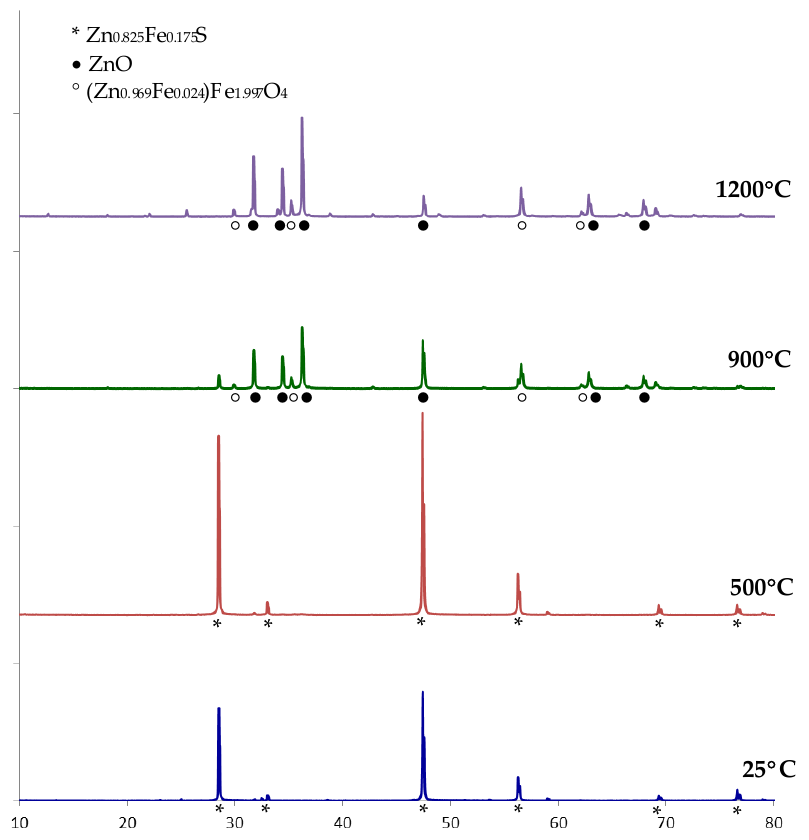
Figure 2. XRD patterns of raw (25 °C) and calcined natural sphalerite (500, 900 and 1200 °C).